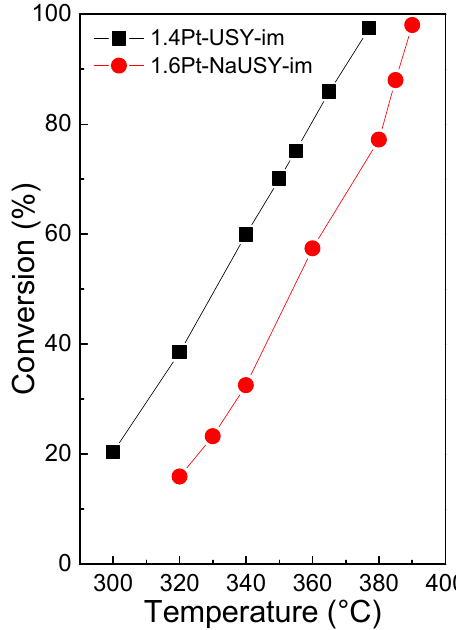
Figure 2. Decalin conversion (%) vs. reaction temperature (°C) obtained for 1.4Pt-USY-im and 1.6Pt-NaUSY-im catalysts. Reaction conditions: T = 300–390 °C, Weight hourly space velocity (WHSV) = 3.22 h − 1 , Pressure (P) = 35 bar, and molar ratio hydrogen/decalin (H 2 /D) = 100.